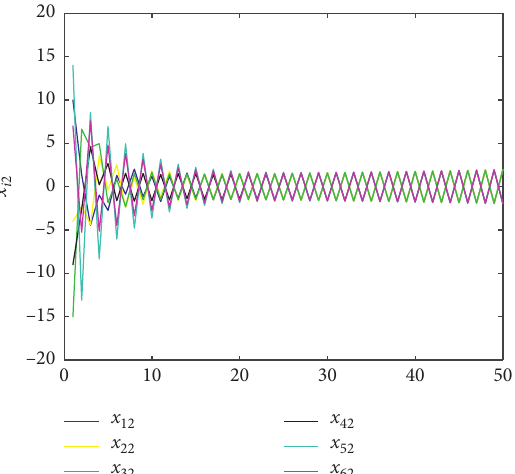
, i � 1 , 2 , ... , 6, under state feedback protocol. i 1